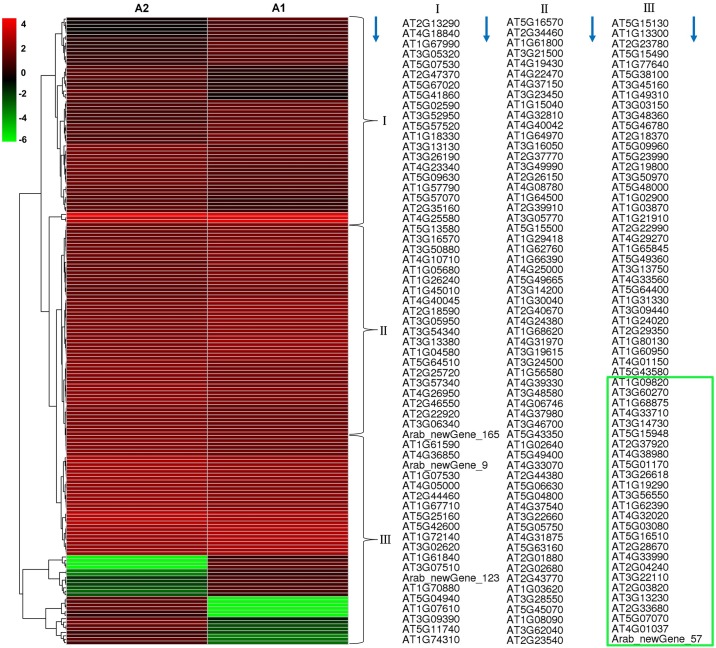
Hierarchical cluster analyses of gene expression based on log ratio RPKM data.The cluster display expression patterns for a subset of DEGs in two comparisons (A1-vs-A2) between two treatments. The color key represents RPKM normalized log10 transformed counts. Red represents high expression, green represents a low expression. Each column represents an experimental condition, and each row represents a gene. The columns are evenly divided into three groups, I, II and III. Each group contains 61 genes, their order are arranged in accordance with the blue arrow direction. The green box contains 26 genes, which represented the green rows in III group.